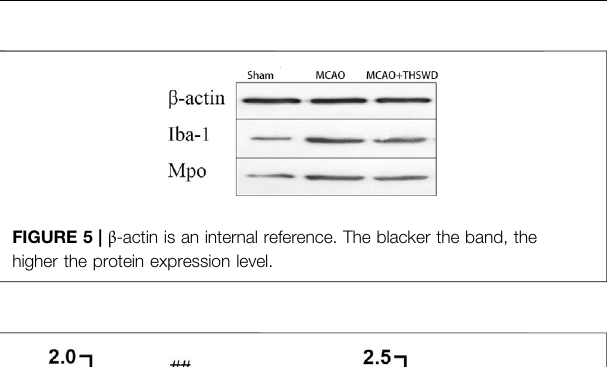
FIGURE 4 | mRNA expression of IBA-1 and MPO. Notes: # P < 0.01 vs Sham operation group; * P < 0.01 vs MCAO group.